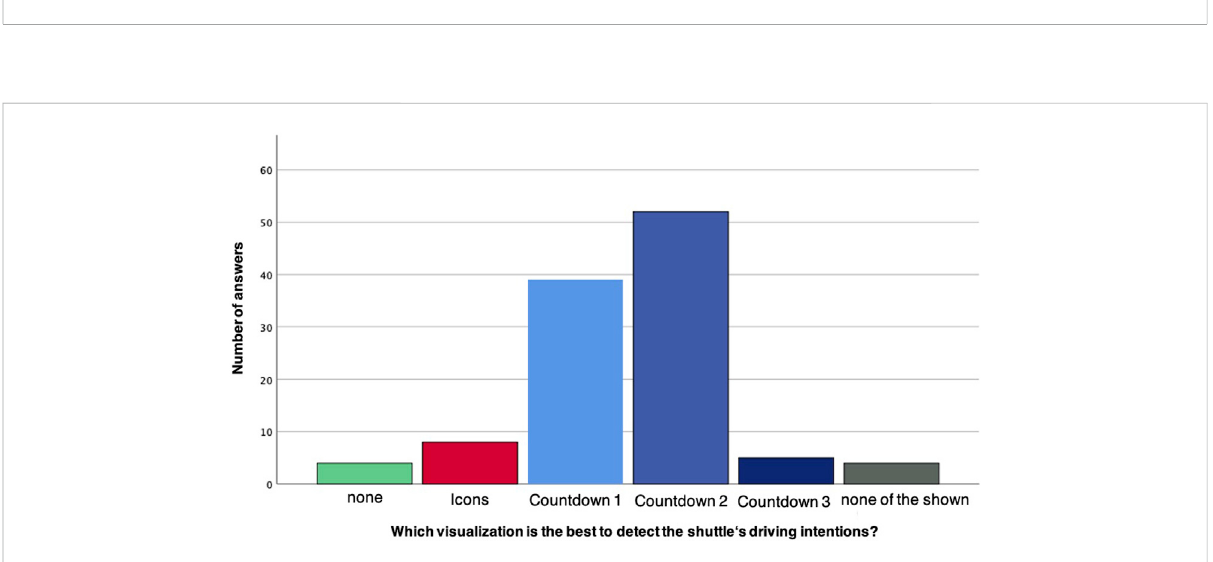
FIGURE 11 Preferred eHMI for detecting the shuttle ’ s intentions during